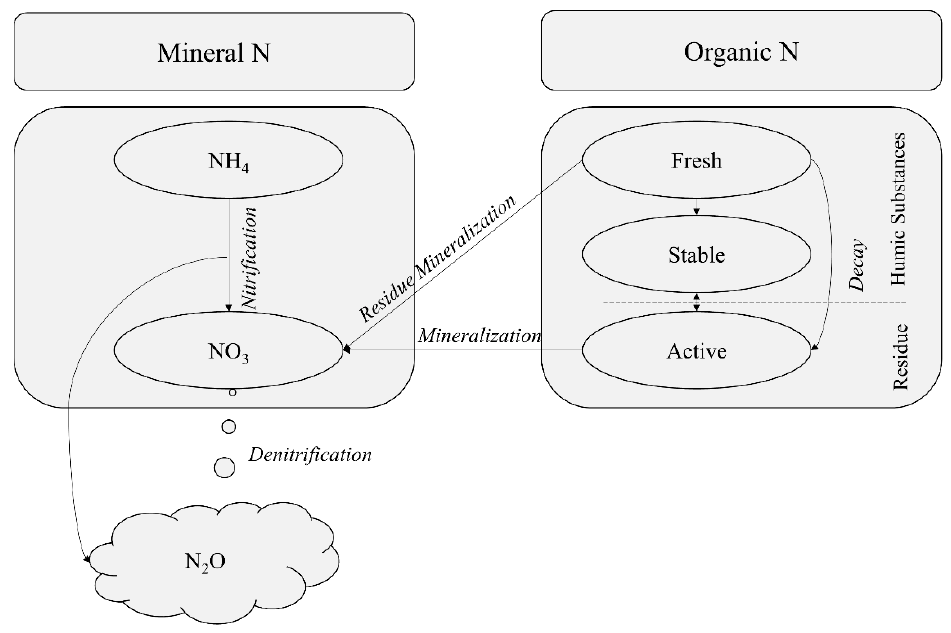
Figure 2. Soil N-cycle in SWAT and the associated N 2 O emissions.